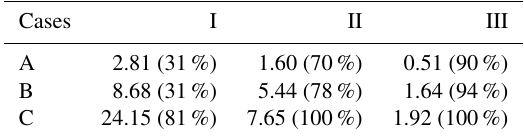
Table 2. Power generated (GW) by the wind farms. Wind farm ef- ficiencies are given in